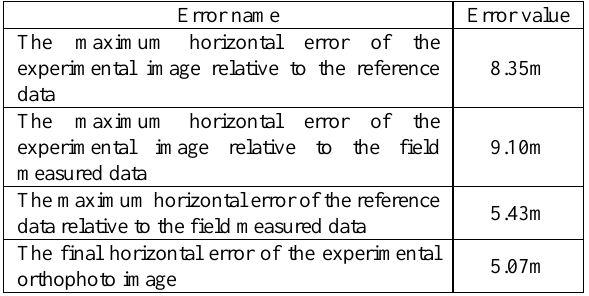
Table 1. Results of horizontal accuracy in experimental